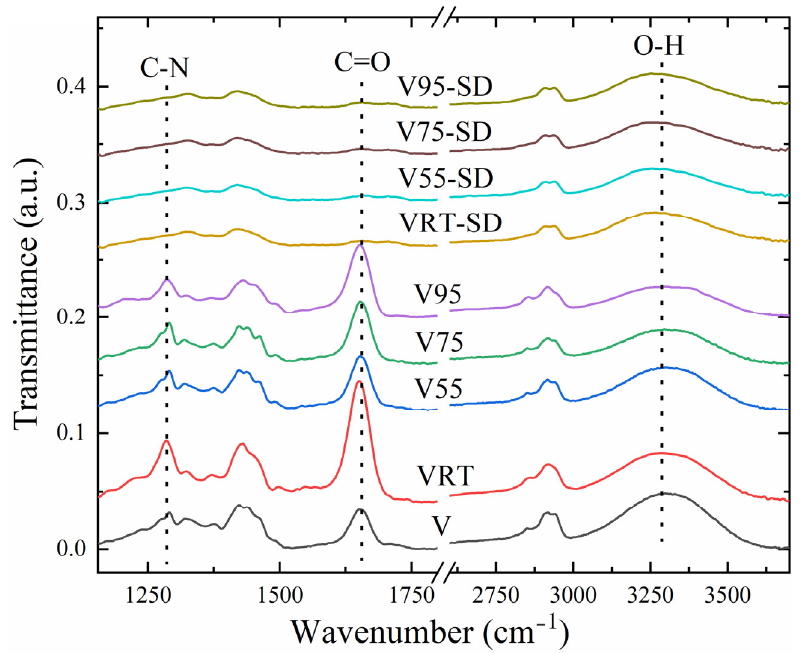
Figure 5. FTIR spectra of the nanofibers in all 9 differently prepared and treated samples.